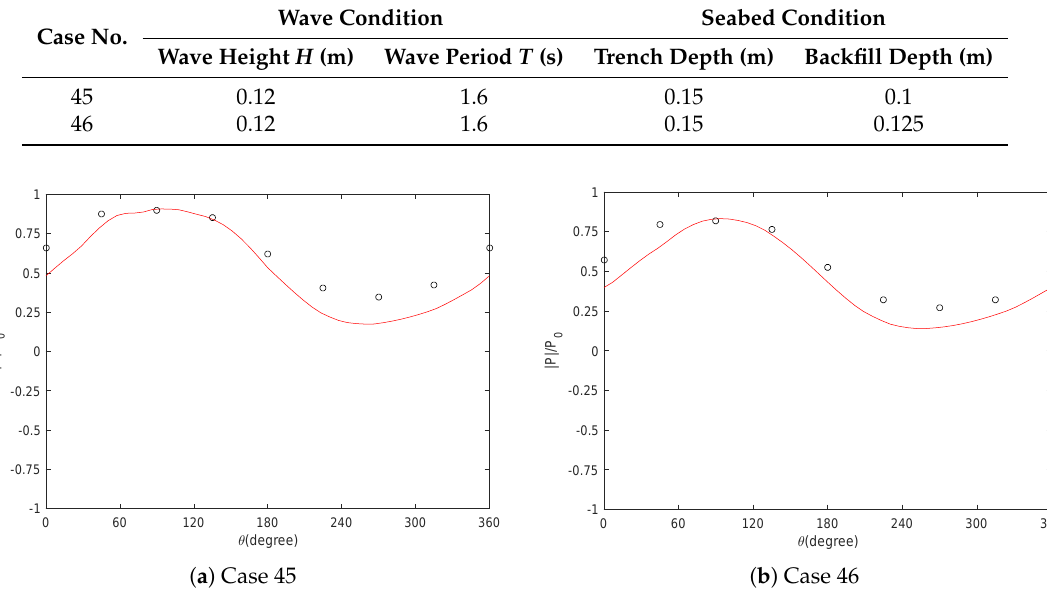
Figure 6. Distribution of wave-induced pore pressure around a trenched pipeline (red solid line: the present result; circle: experimental data